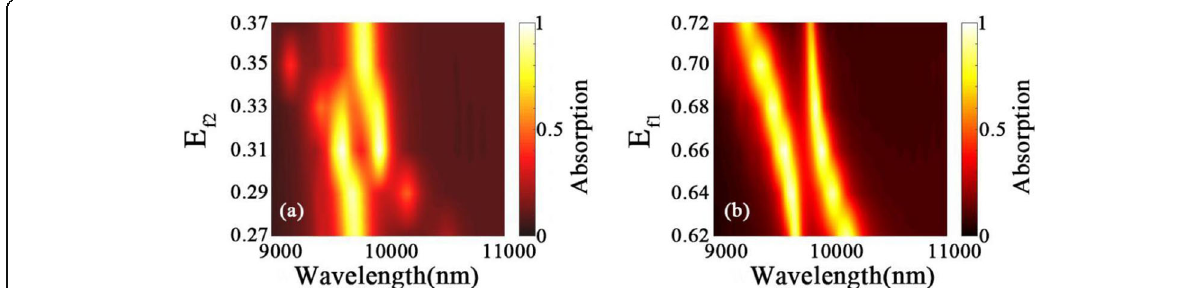
Fig. 6 Absorption spectra as a function of the wavelength and Fermi levels of a lower-layer graphene and b upper-layer graphene. The other structural parameters are the same as Fig. 1